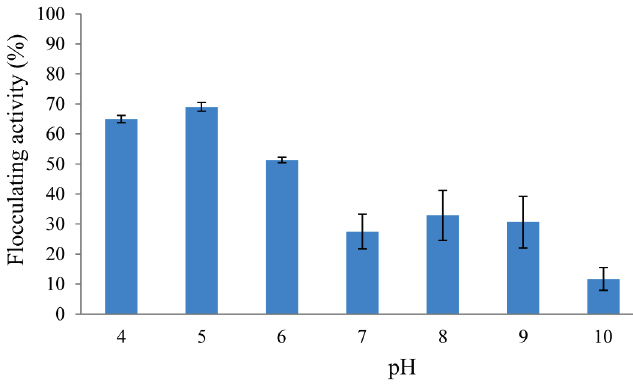
Figure 3. Effect of initial pH of growth medium on REG-6 production by Bacillus toyonensis strain AEMREG6.